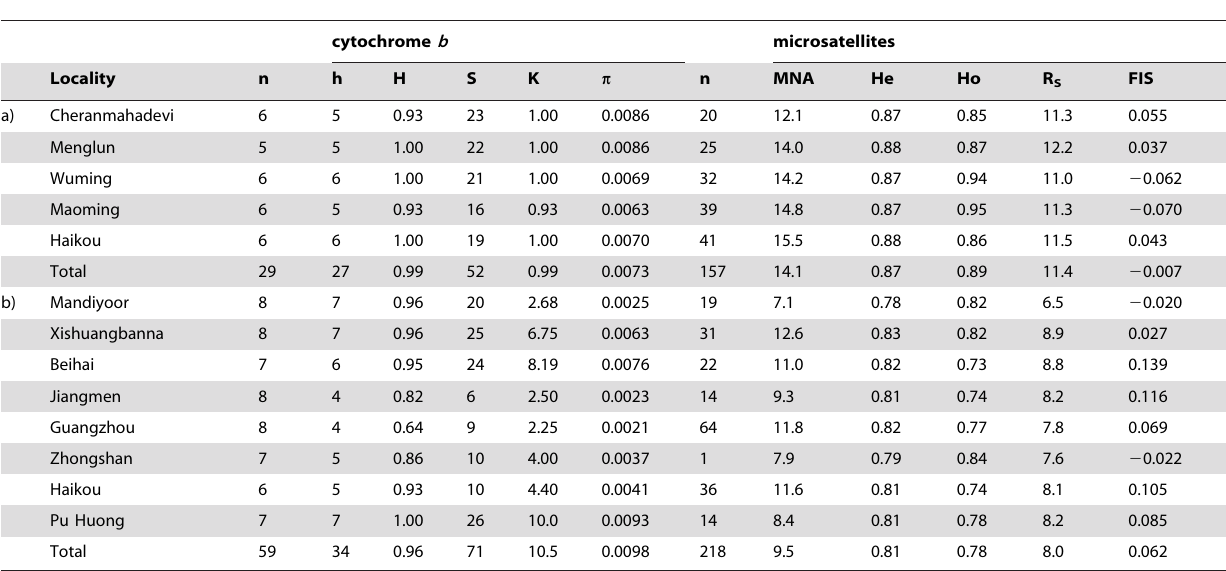
Table 2. Genetic variability based on cytochrome b and microsatellites recorded for a) Rousettus leschenaulti and b) Cynopterus